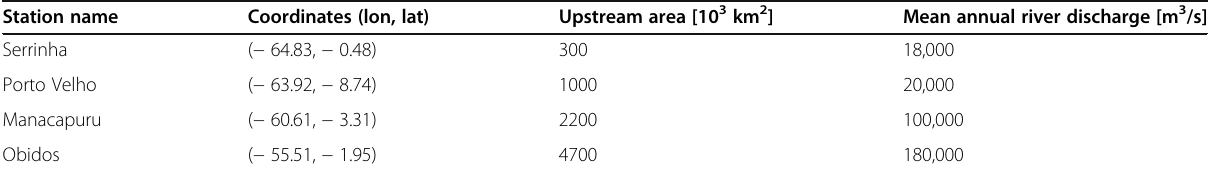
Table 2 Summary of validation stations in the Amazon River basin